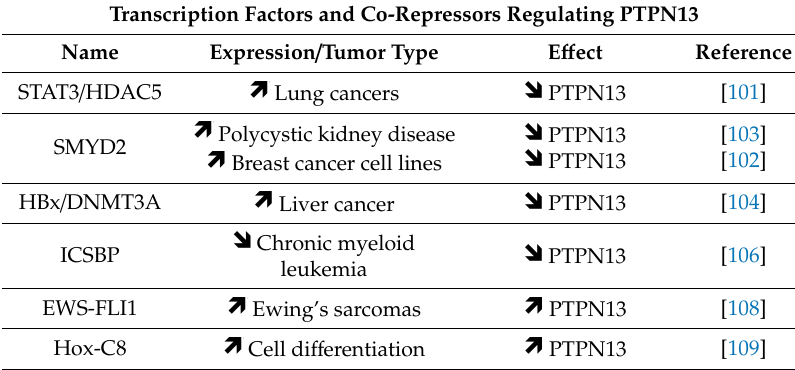
Table 3. Transcription factors and co-repressors regulating PTPN13.